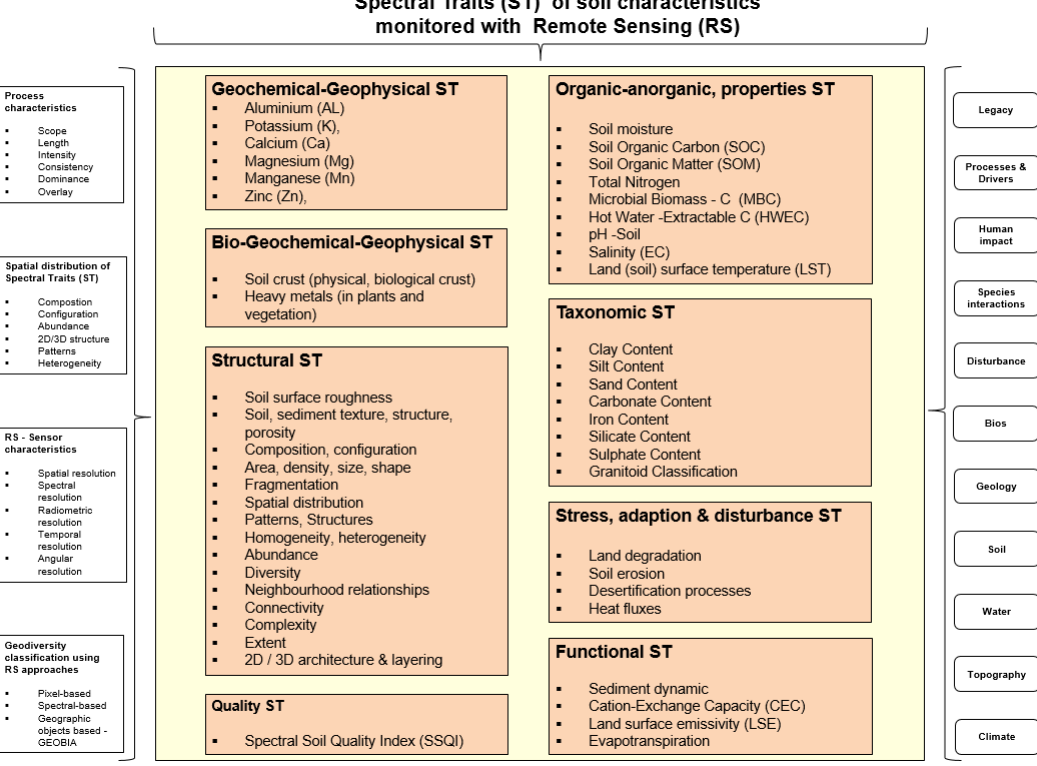
Figure 13. Spectral traits for monitoring soil characteristics and their traits with remote sensing and its constraints (modified after Lausch et al. [1,3]).